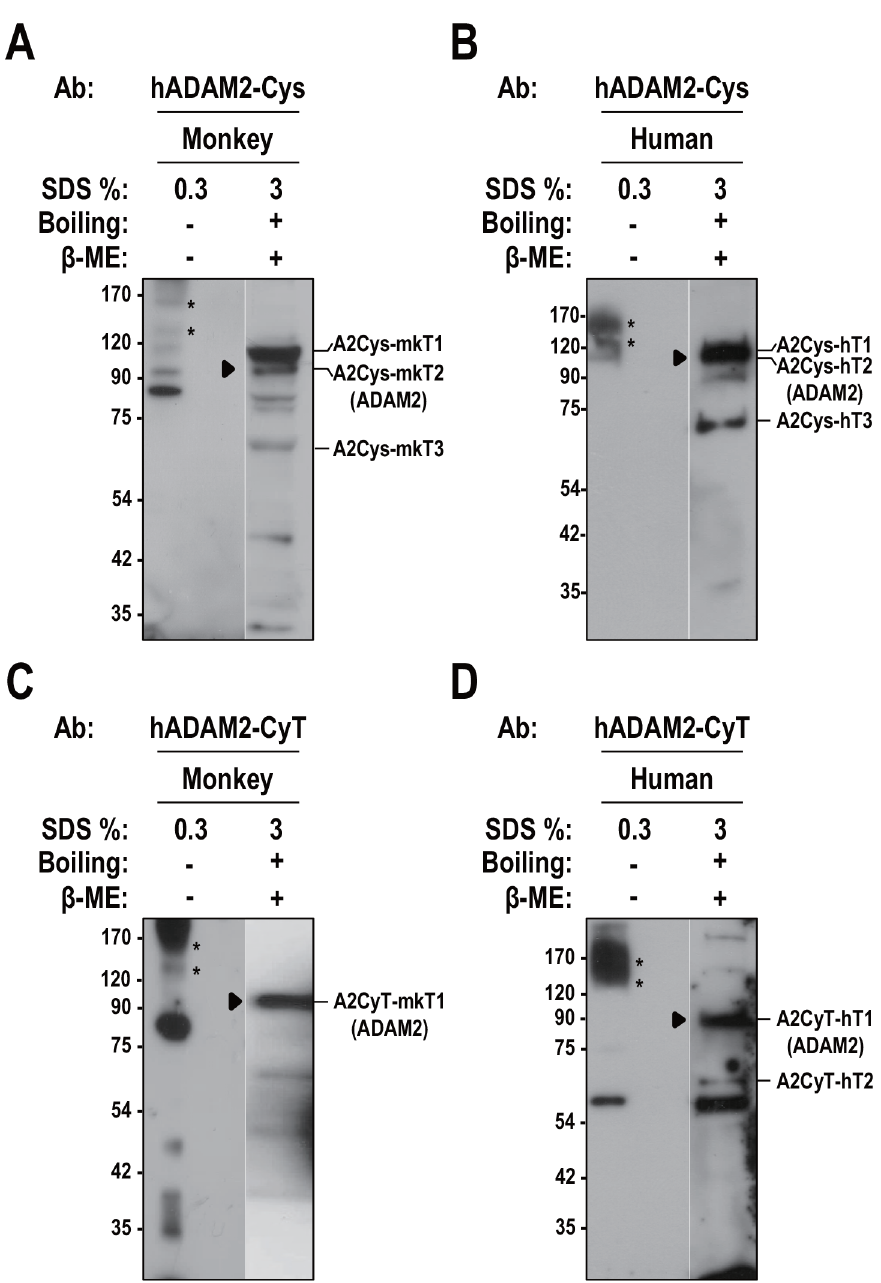
Fig 9. Possible ADAM2 complexes in monkey and human testicular cells. A and C. The non-reduced supernatants from the lysates of monkey testis were either boiled in 3% SDS (lane 2) or incubated at room temperature in 0.3% SDS (lane 1), and then immunoblotted with A. anti-hADAM2-Cys and C. anti- hADAM2-CyT. B and D. A similar experiment was performed using extracts from human testis immunoblotted with B. anti-hADAM2-Cys and D. anti-hADAM2-CyT. Asterisks and arrowheads indicate the ADAM2 complexes and monomers, respectively. Experiments were repeated three times. Reduced and non- reduced potein samples were subjected to SDS-PAGE using 8% resolving gels. Abbreviation: β -ME, β - mercaptoethanol. Molecular masses are presented on the left.